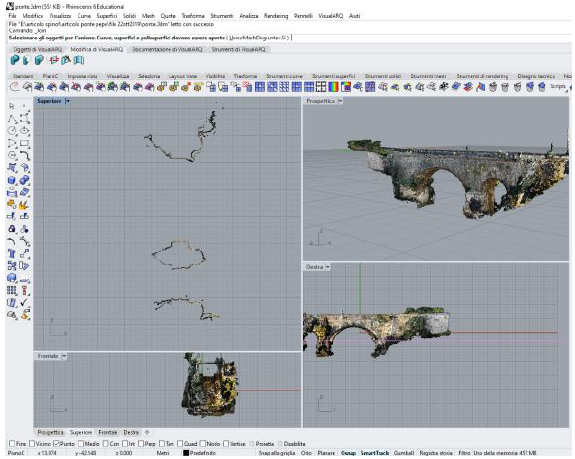
Figure 8. Extraction of sections from point cloud